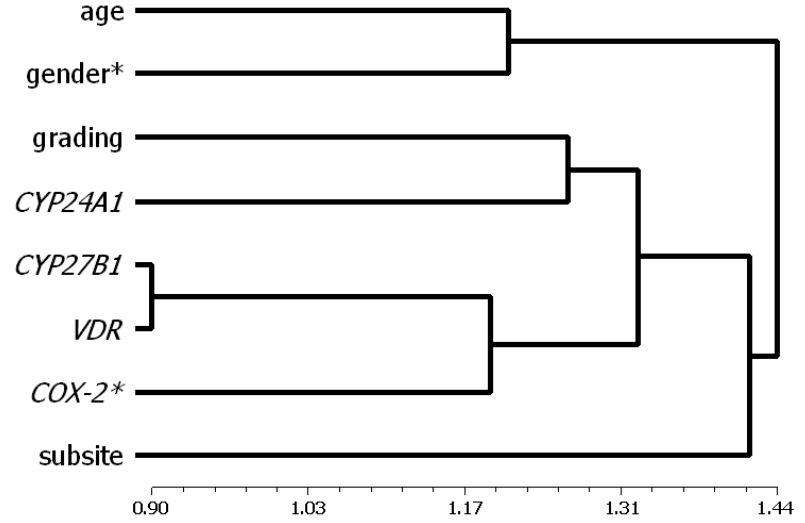
Figure 6. Dendrogram (“hierarchical tree”) showing results of cluster analysis by the UPGMA method with all variables. Asterisk marks variables with salient loadings on two factors in the factor analytical model. On the left of the plot, at the origin of the horizontal axis, each variable is shown as a class by itself. Linkage distance marks the position at which variables can be merged into clusters. Smaller values indicate clusters with strong associations between few variables, whereas clusters at higher values contain more variables though with weaker mutual associations. Patient level analysis of mutual correlations between malignancy, age, gender, subsite location, CYP27B1 , CYP24A1 , VDR and COX-2 (see also